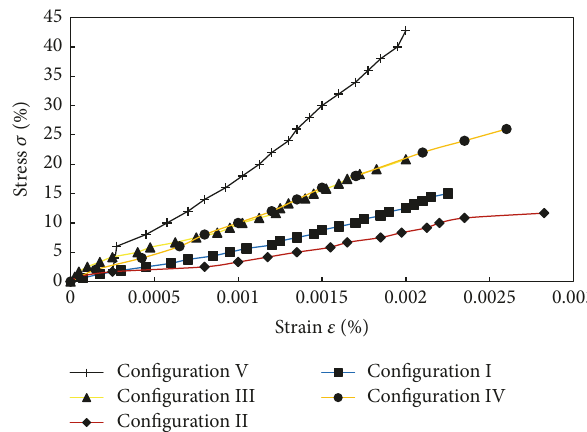
Figure 5: Stress-strain curves of lontar fiber-reinforced composites with different hole